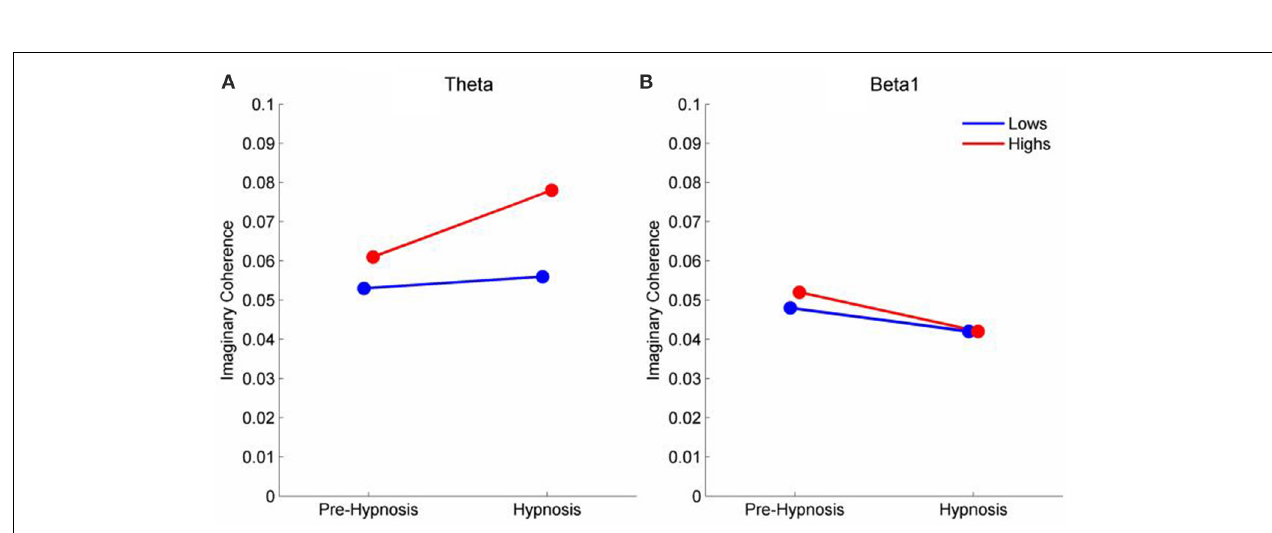
negative loading. Given the Design Scores, the blue lines indicate those connections where there was a decrease in iCOH from the pre-hypnosis state tothehypnosisstateandredlinesindicateanincreaseiniCOH.Thedifferences were most pronounced in the high susceptible participants. (C) Shows the number of significant connections at each electrode site. In this case, there were two clusters of connections; one centered on the vertex (maximal at Cz), and one focused at posterior electrodes (maximal at PO2).